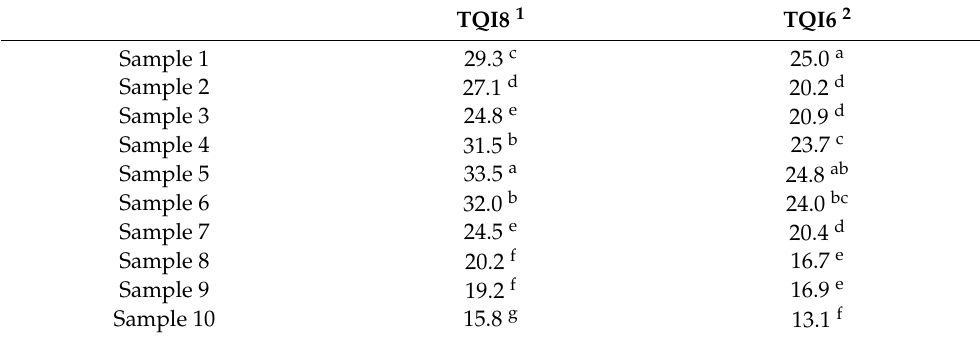
Table 8. The least-squares means for textile-quality indices (TQI) for the 10 textile samples ( α =